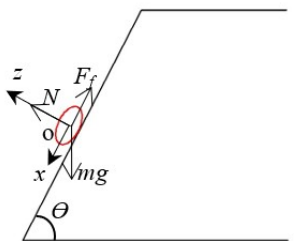
Figure 9. Stress analysis diagram of seed on slope of seed guiding channel.